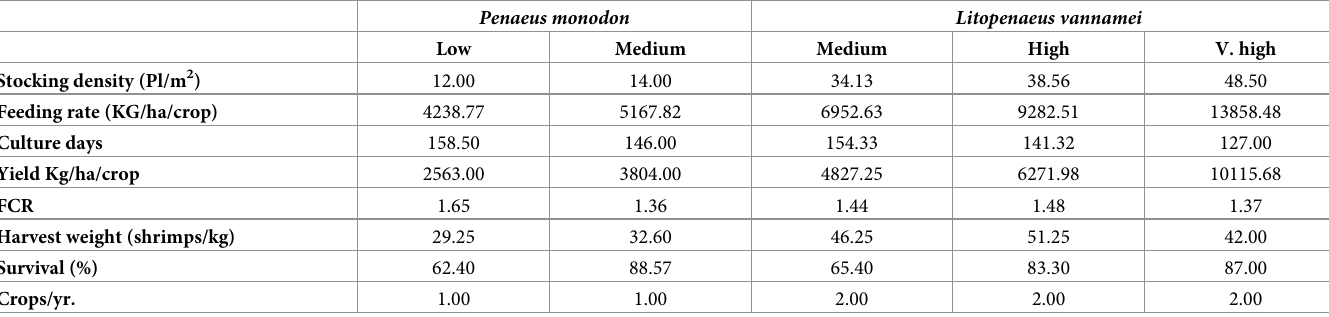
Table 3. Mean values for key production parameters by categories of intensity/yield